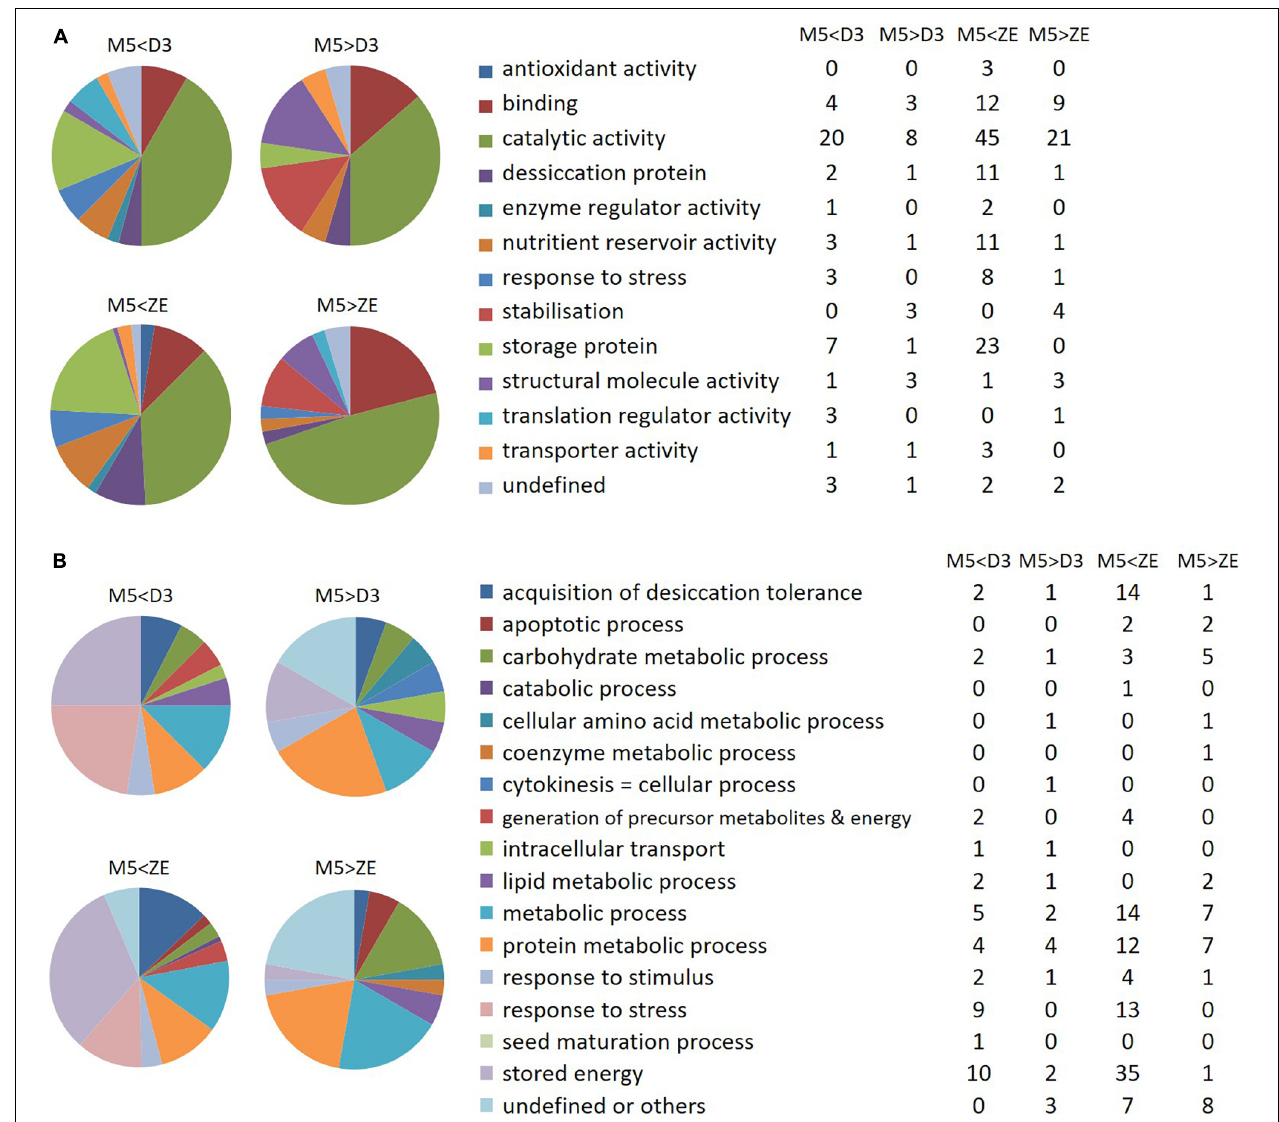
FIGURE 11 | Gene ontology analysis of differentially expressed proteins. (A) Molecular function of the differentially abundant proteins between mature SEs (M5) and fresh ZEs or SEs after three weeks of desiccation (D3). (B) Biological processes modified by the differentially abundant proteins between the proteomes of M5 and fresh ZE, or of M5 and D3. On the left side of the figure, the colors represent the percentages of proteins involved in the indicated molecular function or biological process, whereas on the right side of the figure, the tables indicate the numbers of corresponding proteins. M5 > ZE and M5 > D3: proteins overexpressed in M5 in comparison to ZE or D3; M5 < ZE and M5 < D3: proteins overexpressed in ZE and D3,